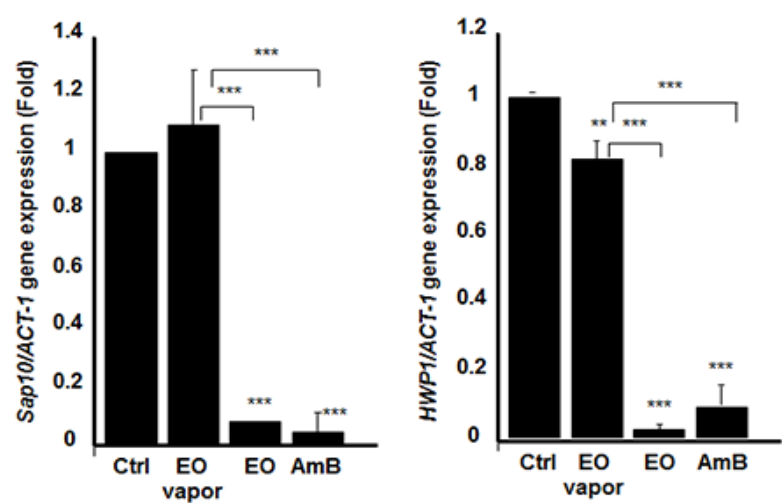
Figure 8. Mentha × piperita essential oil decreased SAP10 and HWP1 gene expression. Following C. albicans culture in the presence or absence of 10 μL/mL of EO or its vapor, or AmB (1 μg/mL ) for 6 h at 30 °C, total RNA was extracted from each cell culture and qRT-PCR was performed using specific primers for SAP10 or HWP1 . ACT-1 was used as the housekeeping gene for internal control. The plotted values refer to the ratio Gene of interest /ACT-1. The changes in mRNA levels are presented as the fold expression of the gene in the test sample compared with this gene’s expression in the control (without EO). Results are expressed as the means ± SD, n = 3. *** p < 0.001. The free asterisks refer to the statistical difference when comparing EO effects to control. The bars with asterisks showed the comparison of EO vapor to the EO liquid, and to the